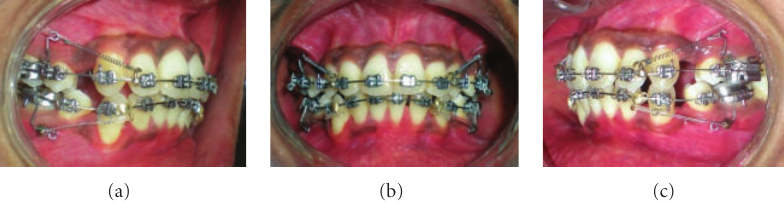
Figure 10: (a, b, c) Simultaneous en-masse retraction was continued in both arches. Closed coil springs were used for the en-masse retraction which were stretched and engaged posteriorly over MSPA and anteriorly to hook soldered on archwire. Although miniscrews were placed towards occlusal level, forces exerted by the springs were directed apically and towards Cres of posterior teeth.